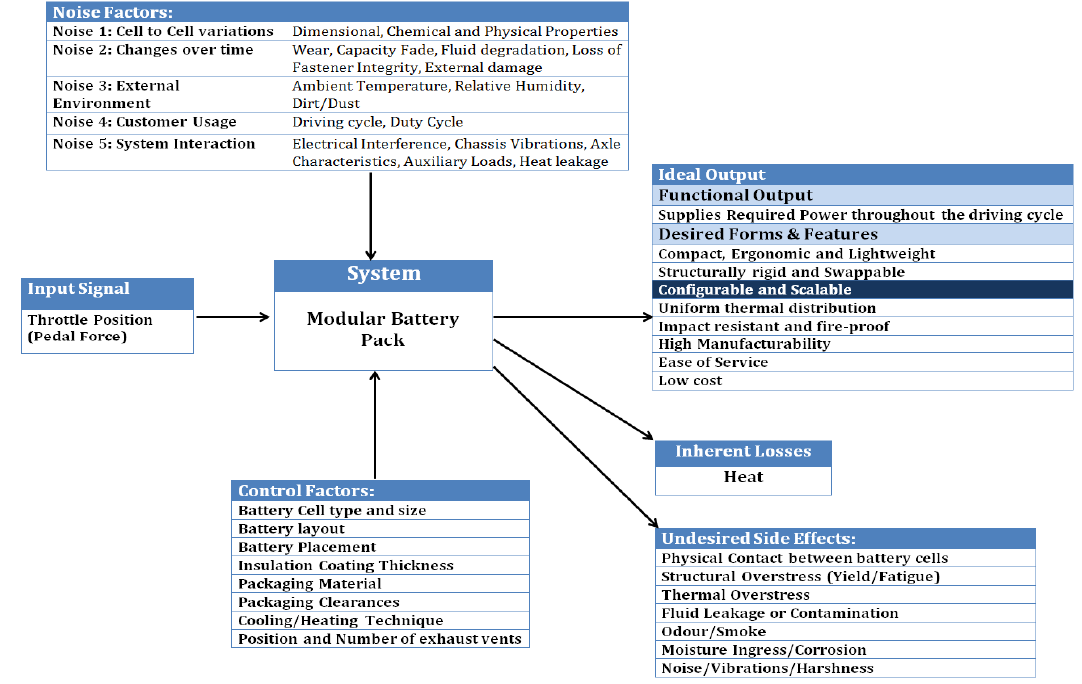
Figure 8. Modified P ‐ diagram for a modular EV battery pack.